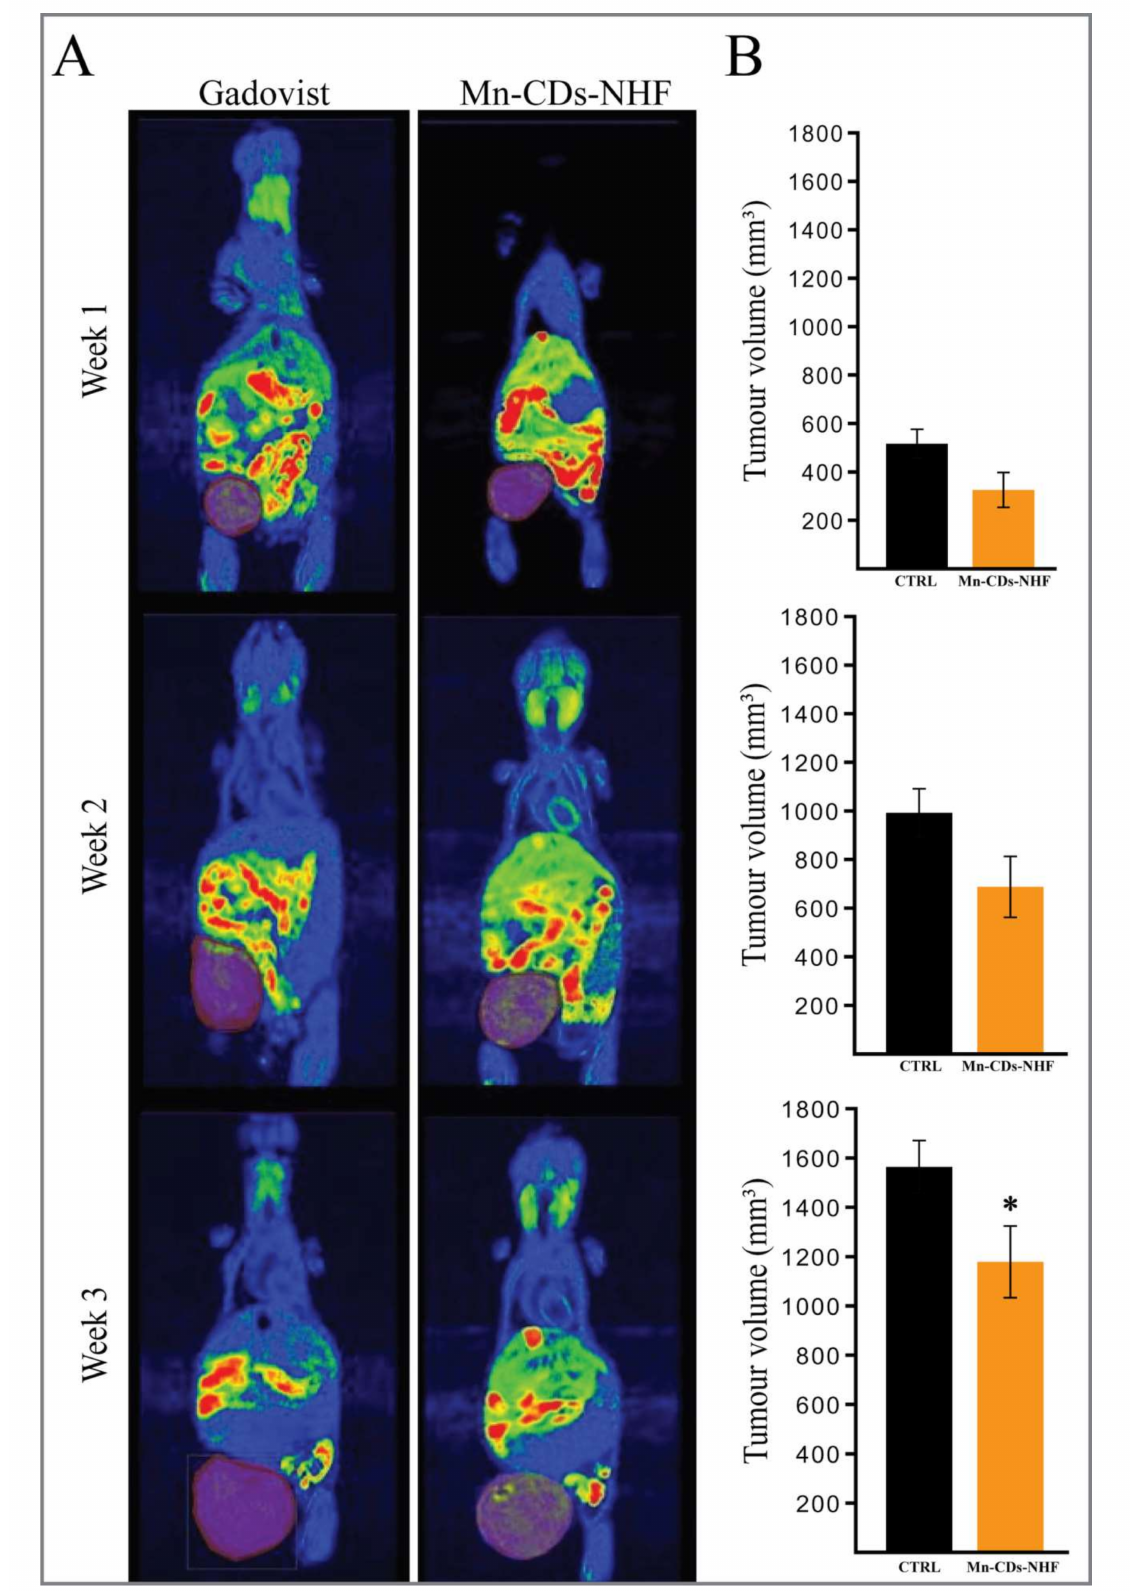
Figure 4. Representative MRI images and scorization of primary tumor volume. ( A ). Weekly images of tumor-bearing mice treated with Gadovist or Mn-CDs-NH. ( B ): Scorization of primary tumor volume for each treated group. * p <